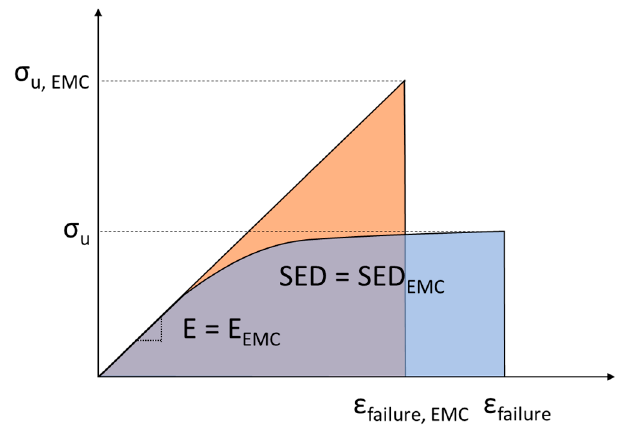
Figure 2. Tensile stress-strain curves for the real material (ductile) and the EMC material (linear-